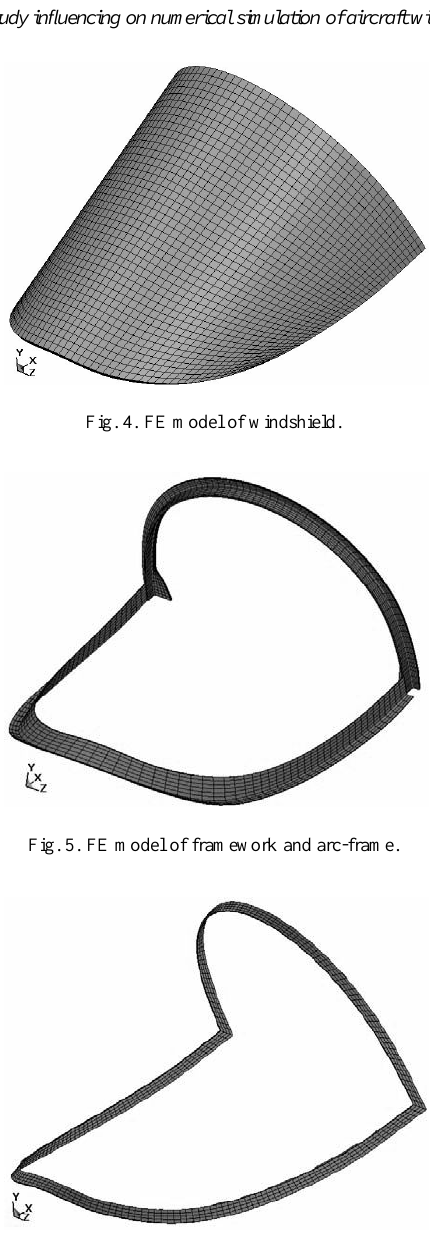
Fig. 6. FE model of